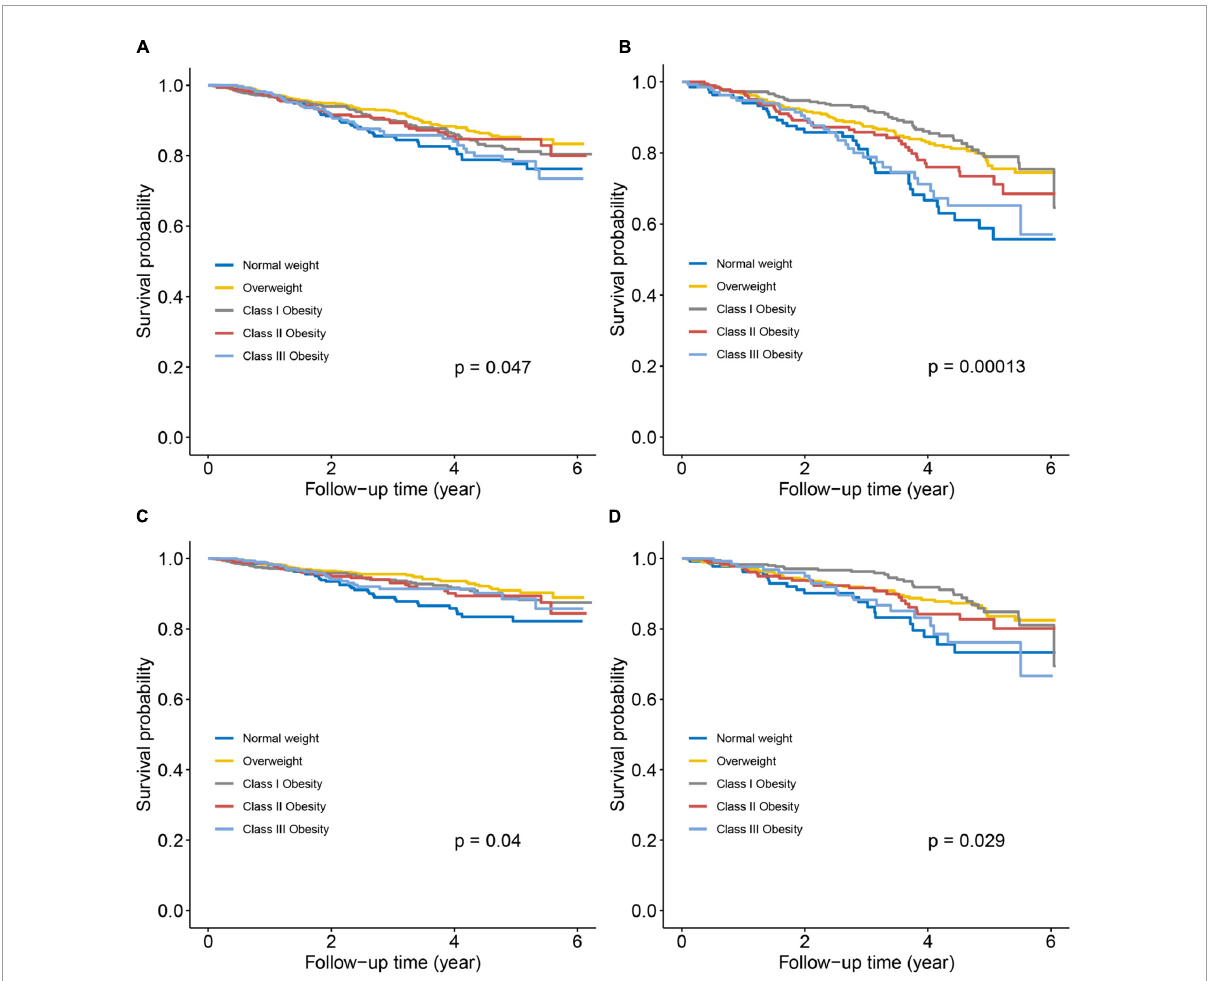
FIGURE2 Kaplan–Meier survival curves for all-cause death (A,B) and cardiovascular death (C,D) according to baseline BMI categories in HFpEF patients with non-ischemic and ischemic etiology. (A,C) Non-ischemic HFpEF; (B,D) ischemic